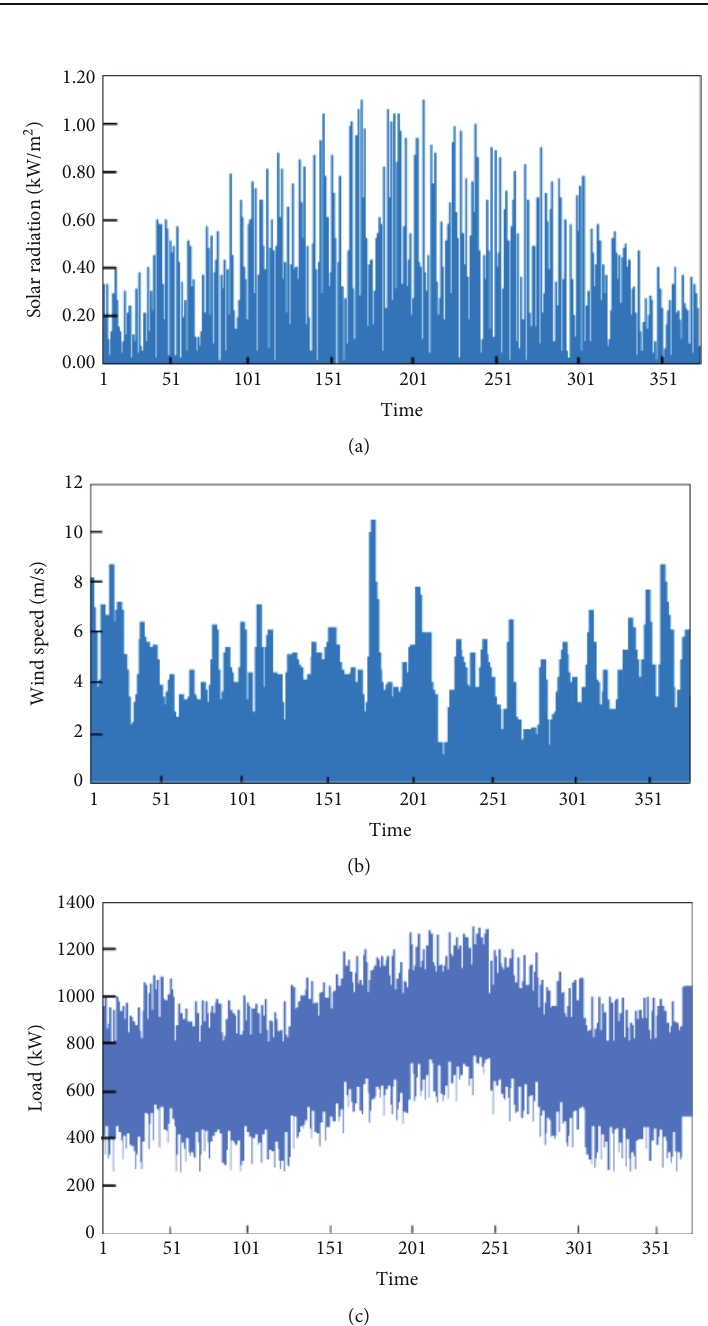
Figure 8: Environmental data and residential load curve. (a) Solar radiation curve. (b) Wind speed curve. (c) Residential load